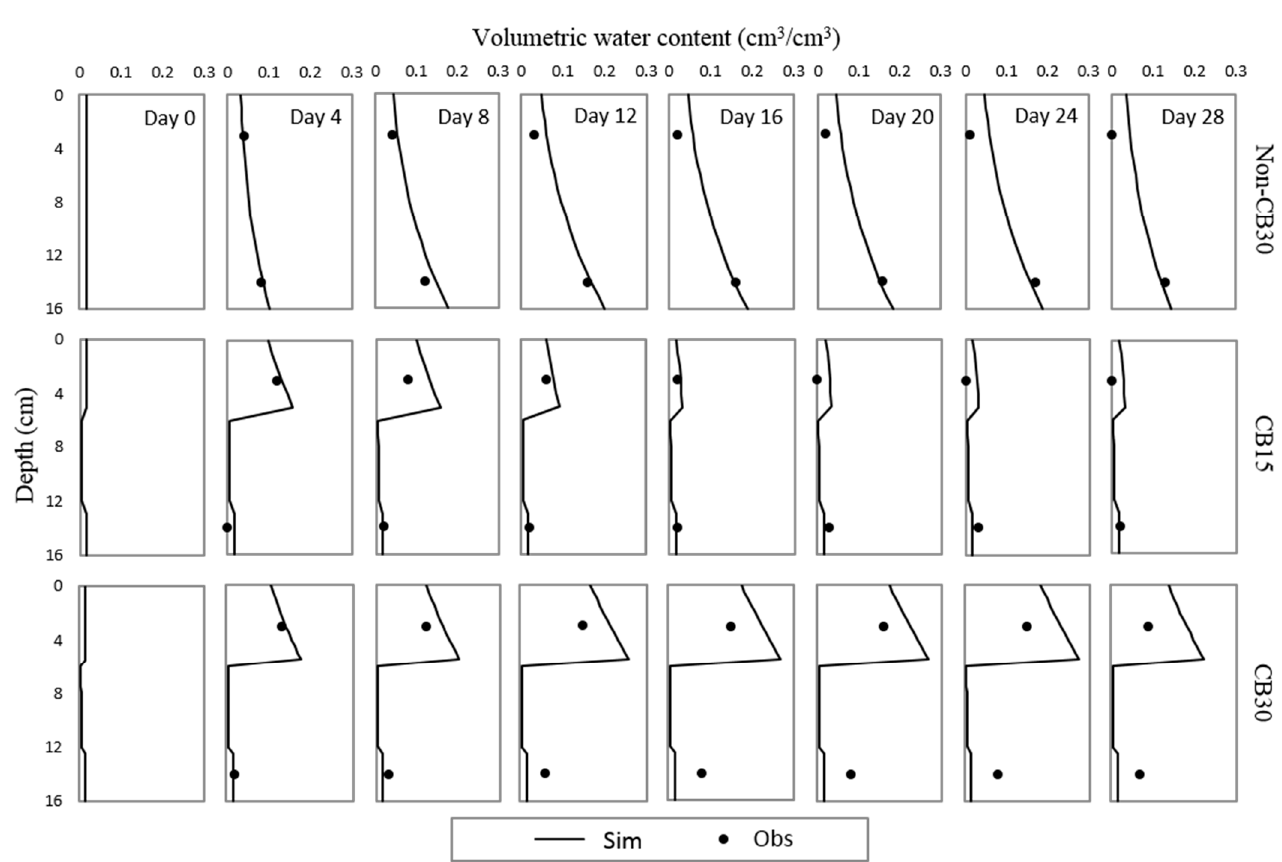
Figure 5. Simulated and observed volumetric soil water contents at different times (0, 4, 8, 12, 16, 20, 24, and 28 d; from left to right) and for different experimental setups (Non-CB30—A homogeneous reference column and daily irrigation of 0.30 cm ( top ), CB15—A column with a CB and daily irrigation of 0.15 cm ( middle ), and CB30—A column with a CB and daily irrigation of 0.30 cm ( bottom )).